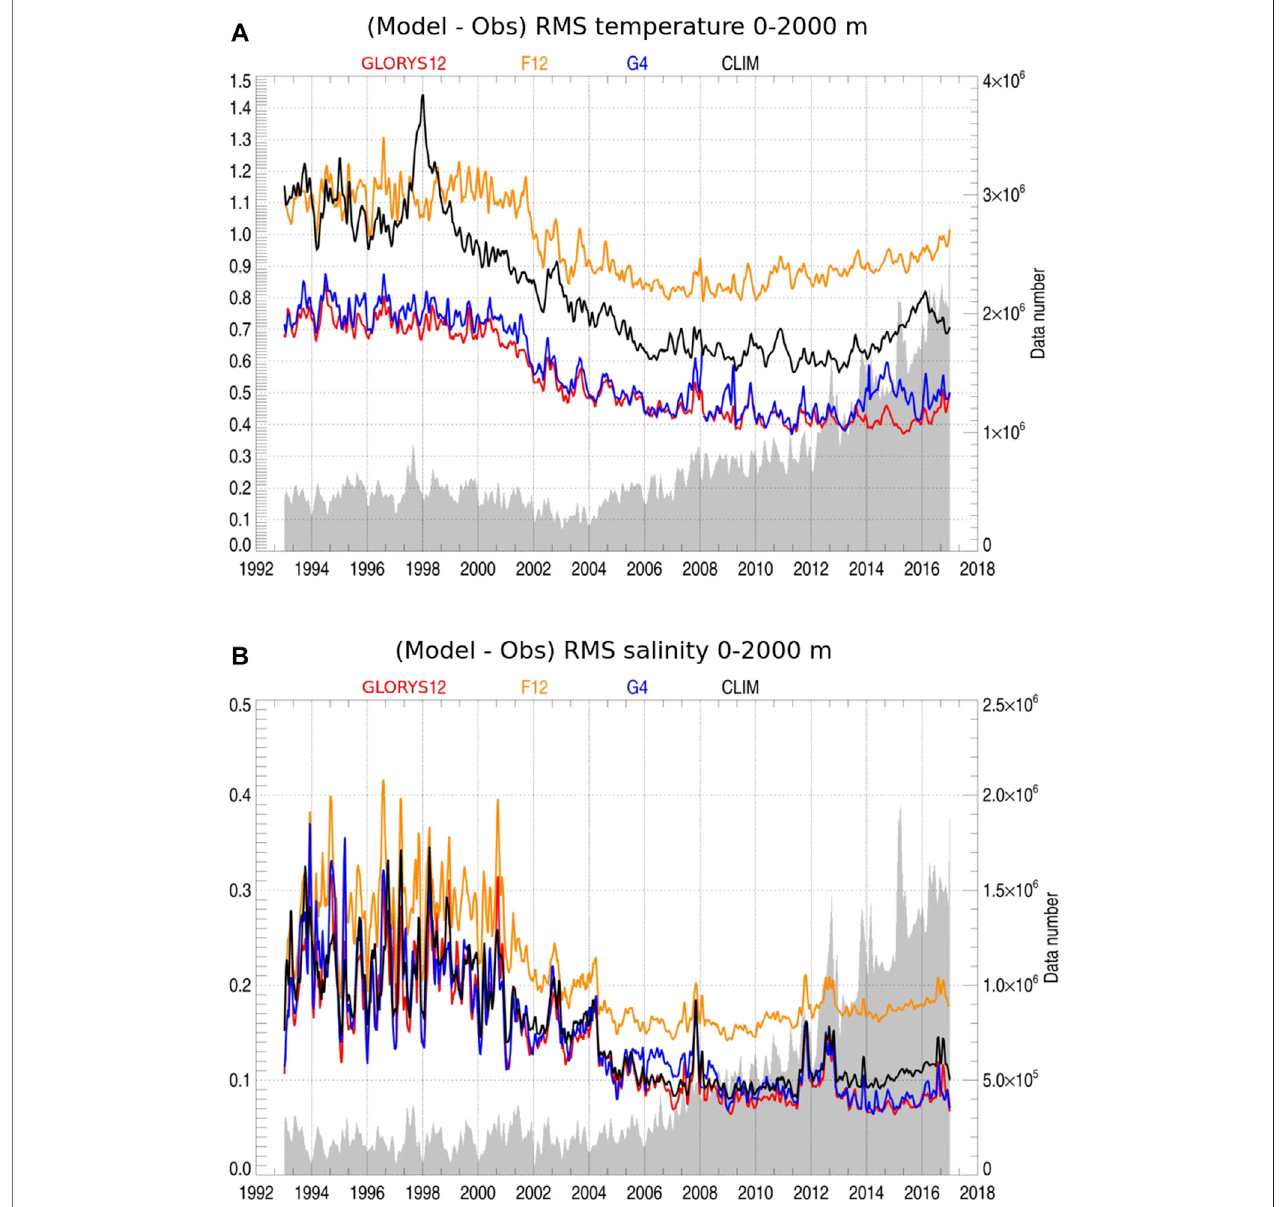
FIGURE 2 | Time series over the 1993 – 2016 period of the 0 – 2,000 m RMS difference between the model analysis (best model trajectory) and the in situ T/S observations from the CORA database for GLORYS12 (in red), F12 (in orange), G4 (in blue) and Levitus WOA13 climatology (in black): (A) Temperature (units in ° C), (B) salinity (units in psu). Time series of the number of available observations appear in grey.